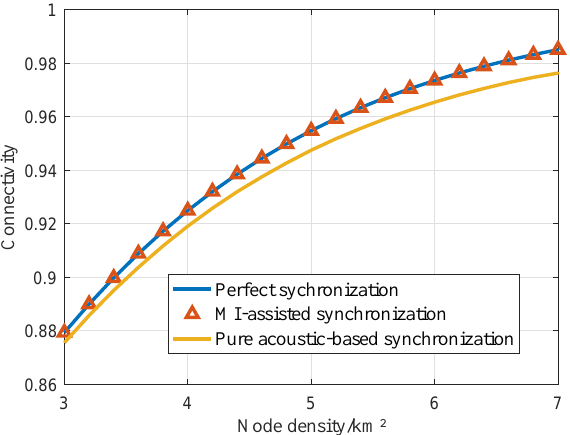
Figure 10. The directly connected probability of the j th cluster with SNR th = 20